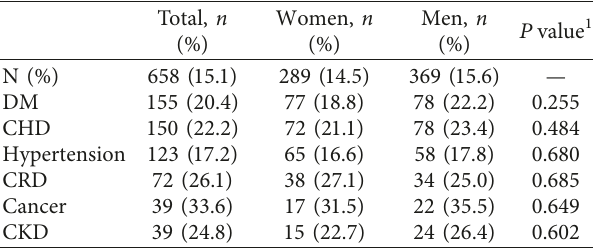
Table 2: Frequency of comorbidities in discharged and deceased hospitalized patients with positive real-time reverse-transcription polymerase chain reaction test results for COVID-19.